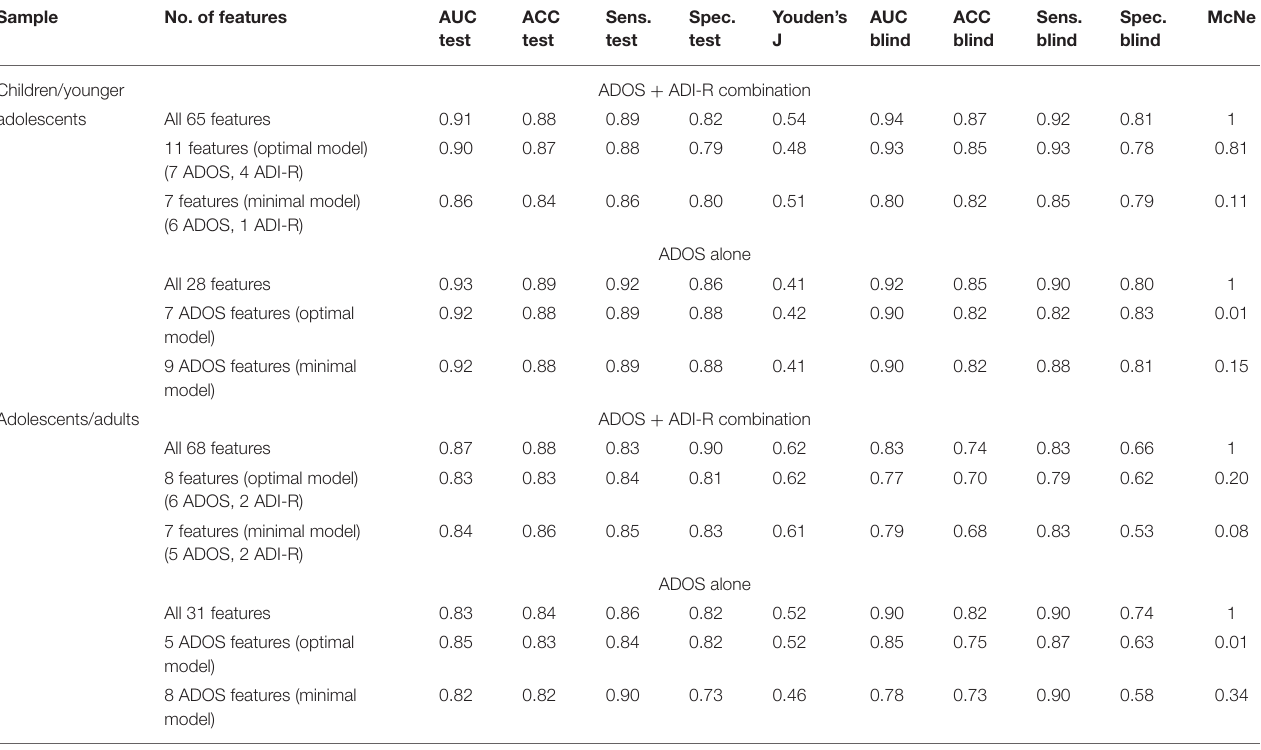
TABLE 2 | Performance of the machine-learning models on the test set and the previously unseen validation data set for the two subsamples of children/younger adolescents (ADOS module 3 and associated ADI-R data) and adolescents/adults (ADOS module 4 and associated ADI-R data).